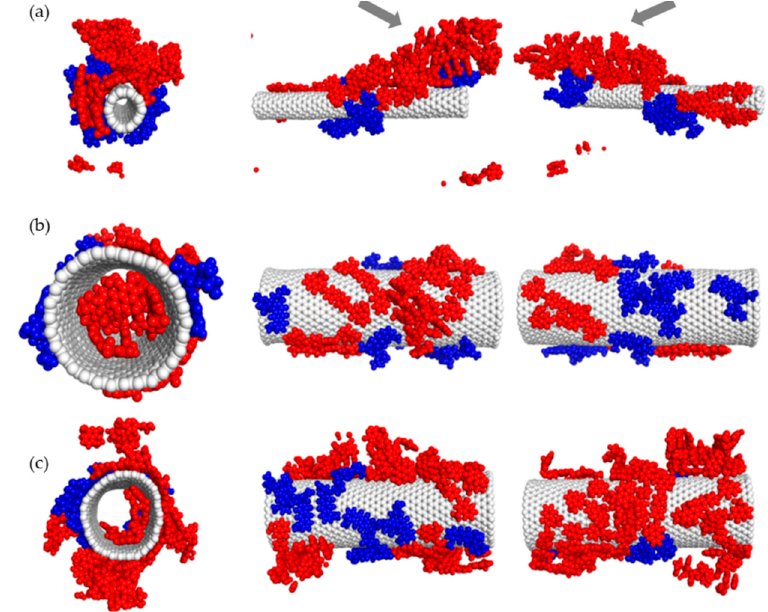
Figure 7. The structure of SWNT-CR-DOX systems at pH < 5.0. ( a ) system composed of SWNT (10.0), 20 CR molecules (red) and 10 DOX molecules (blue), arrows show ribbon-like CR structure; ( b ) system composed of SWNT (30.0), 20 CR molecules and 10 DOX molecules; ( c ) system composed of SWNT (30.0), 40 CR molecules and 10 DOX molecules. Ionic strength of the solution was 0.145 M.